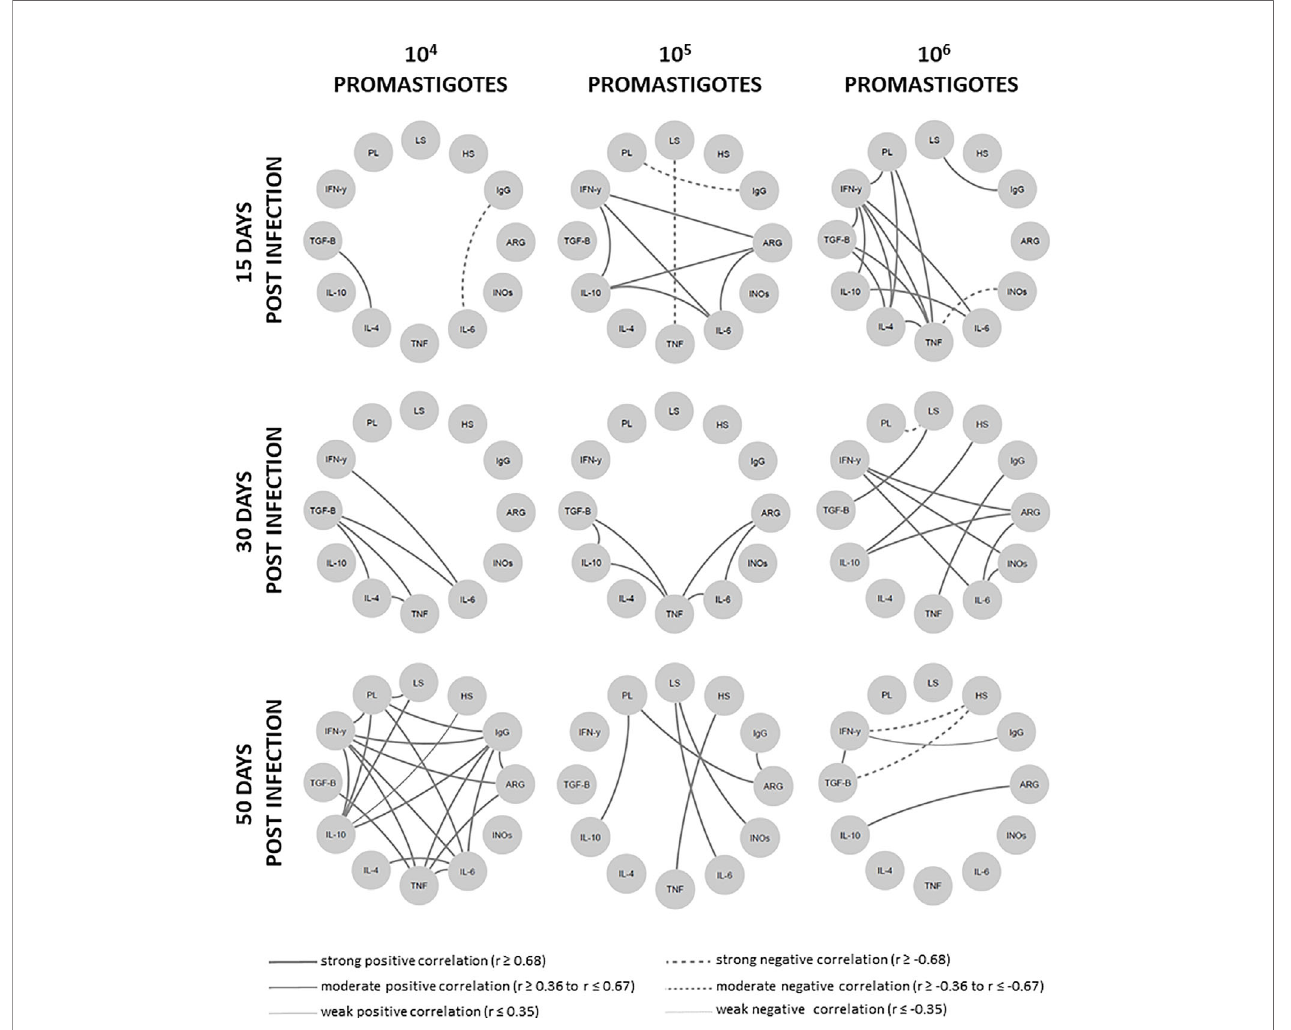
FIGURE 6 | Network interaction involving clinical, parasitological and immunological biomarkers in hamsters infected with different Leishmania Vianna braziliensis inocula. Hamsters were evaluated during the fi rst hours (4h, 24h), early (15 days and 30 days) and phases (50 days) post infection phases with 10 4 , 10 5 or 10 6 promastigotes. Signi fi cant Spearman correlations were considered when p ≤ 0.05, represented by lines connecting the circle nodes. The correlation index strength was represented by the connecting line thicknesses. PL, parasite load; LS, lesion size; HS, histopathology score; ARG, arginase; INOs, Oxid nitric sintase; Cytokine genes – TNF, TGF- b , IFN- g , IL-10,